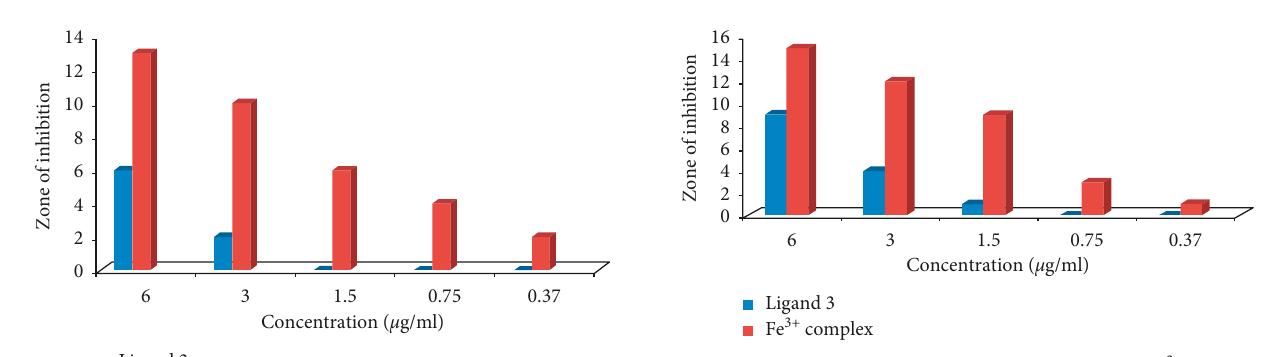
Figure 9: Antifungal activity of ligand 3 (L) and its Fe 3+ complex against R. stolonifer (fungus) concentration ( μ g/mL).